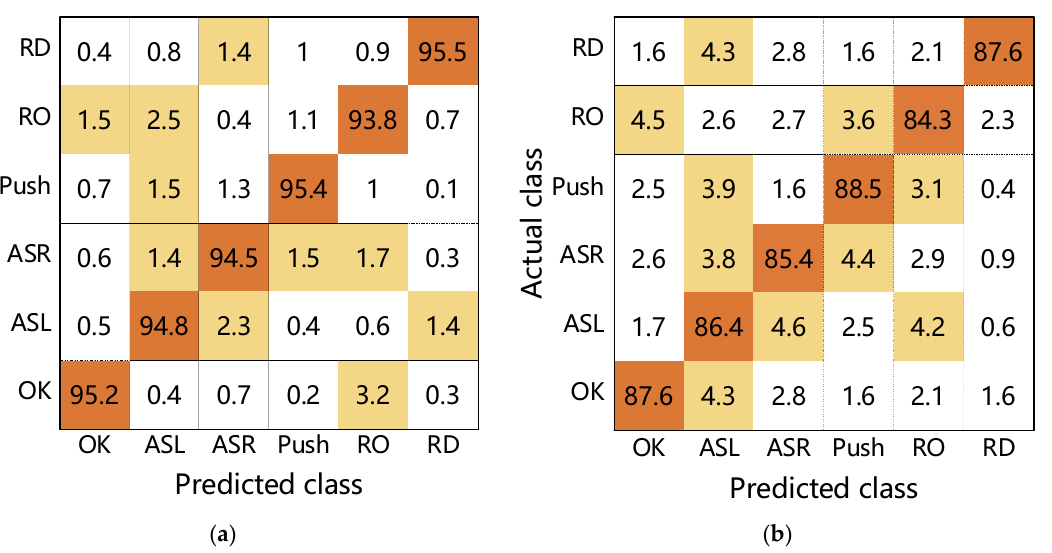
Figure 18. The influence of the environment on gestures: ( a ) The effect of static environments on gestures. ( b ) The effect of dynamic environments on gestures.